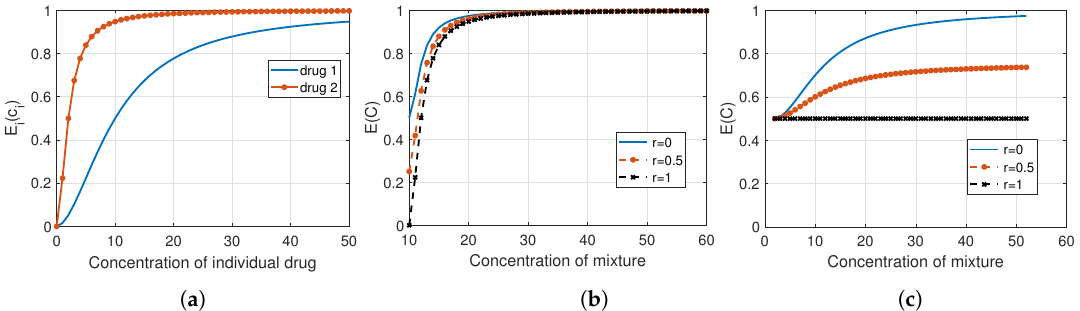
Figure 4. The combination effects of Bliss’s model; ( a ) The response of two combining agents; ( b ) The combination effect for different values of the correlation factor r , when the concentration of drug 1 is fixed at its EC 50 value while the concentration of drug 2 is varied; ( c ) The combination effect for different values of the correlation factor, when the concentration of drug 1 is varied while the concentration of drug 2 is fixed at its EC 50 value.